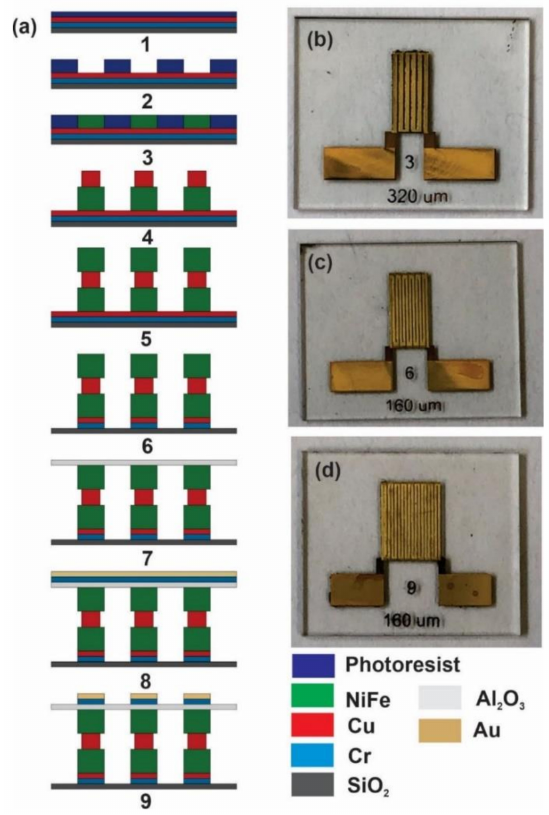
Figure 2. The fabrication process of the MI biosensor. ( a ) The preparation process of the meander thin-film MI biosensor. ( b ) A photograph of the 3-turn biosensor (turn width 320 µ m). ( c ) A photograph of the 6-turn biosensor (turn width 160 µ m). ( d ) A photograph of the 9-turn biosensor (turn width 160 µ